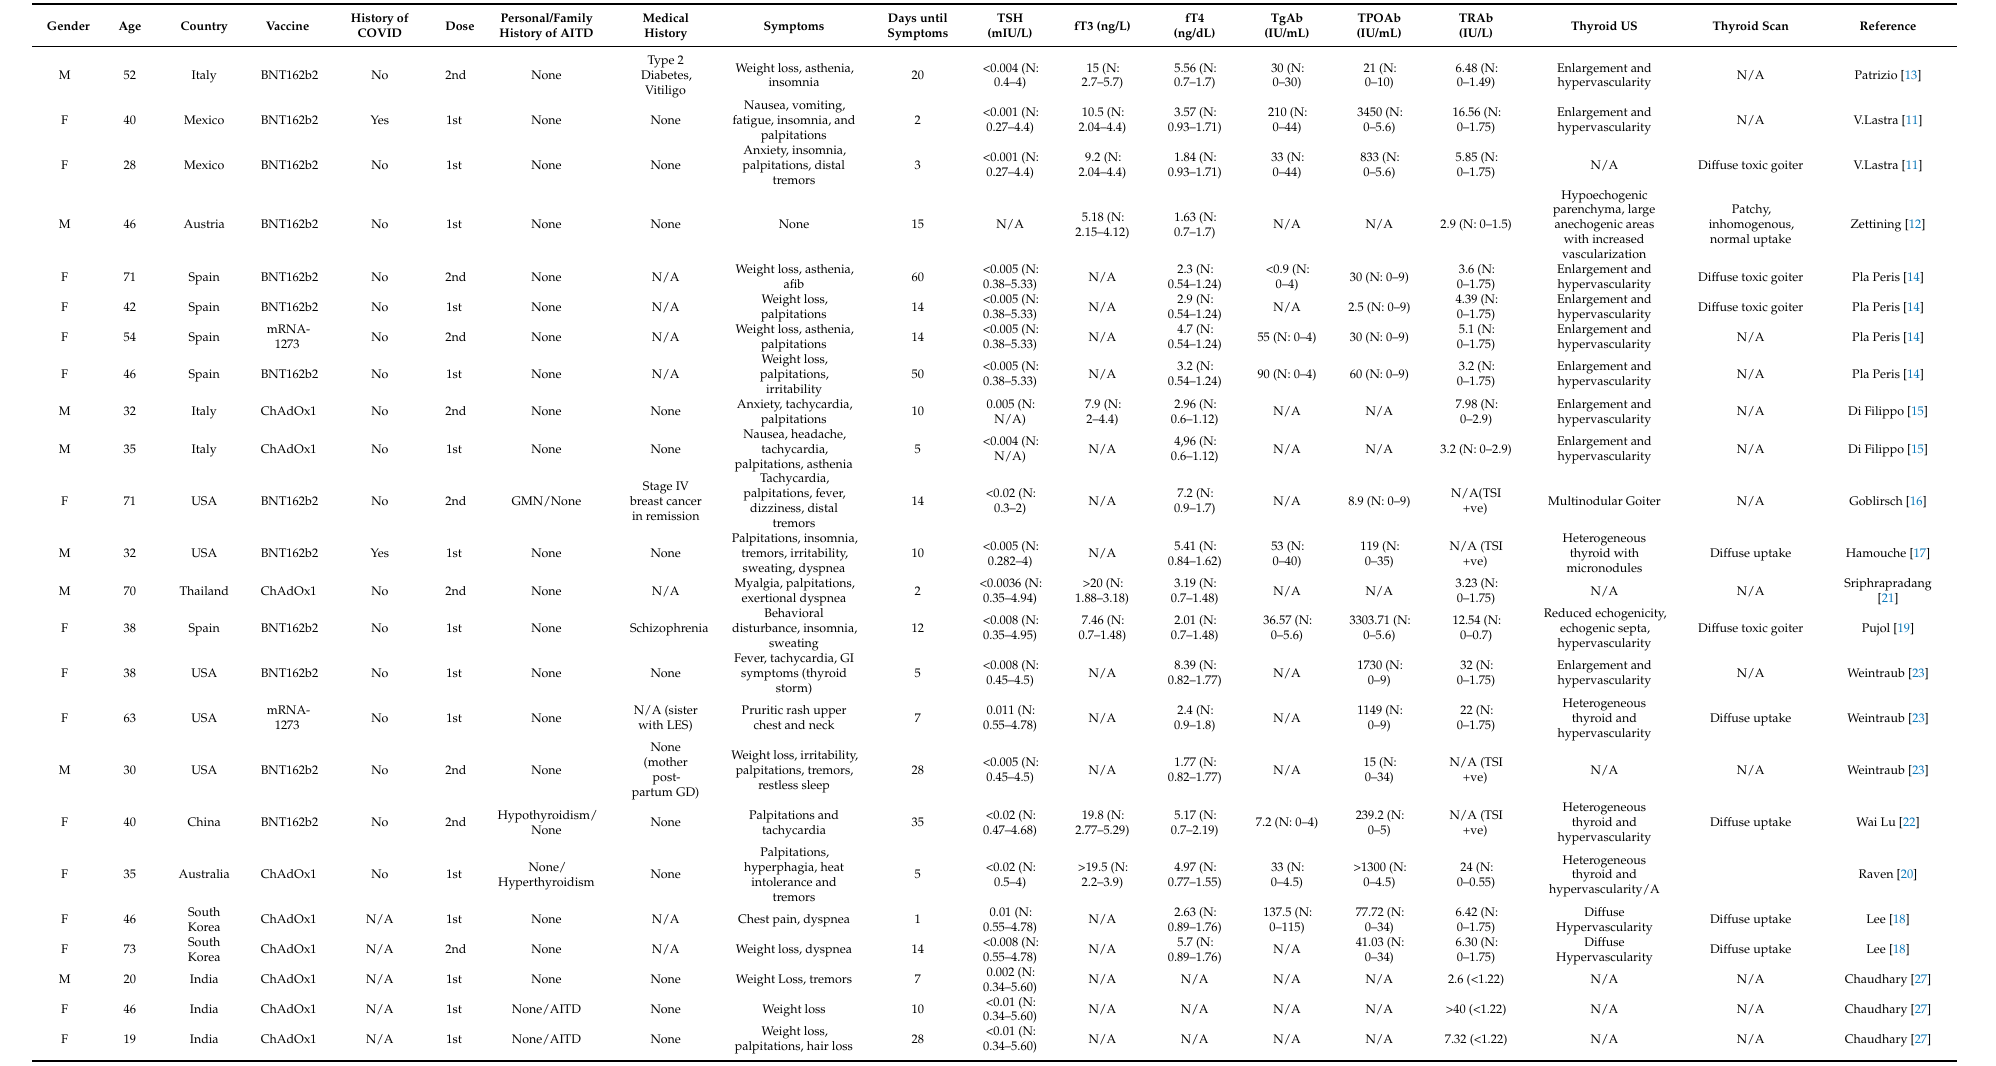
Table 1. Summary of demographic, clinical, and laboratory characteristics of new Graves’s disease cases following SARS-CoV-2 vaccination in the